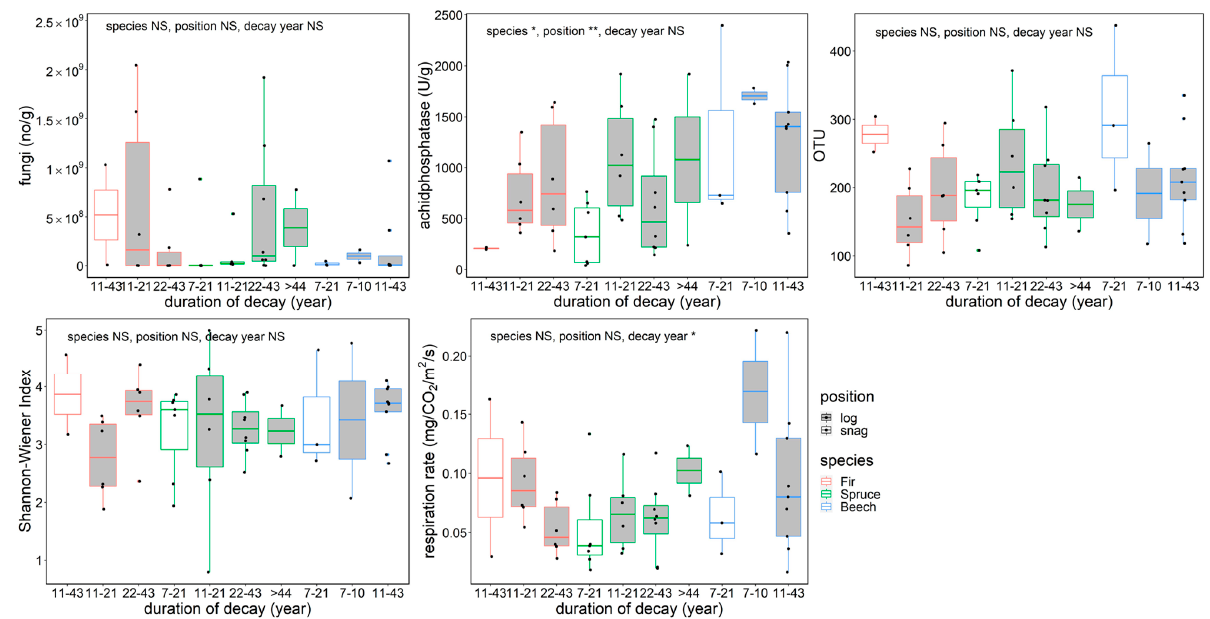
Figure 2. Physico–chemical and biological features and in situ respiration rate of beech, spruce, and fir dead wood snags and logs in an old-growth forest in the Zofin Forest by species and duration of decay. The significance of the effect of tree species, dead wood position, and decay length are indi- cated with asterisks (ANOVA, * p < 0.05, ** p < 0.01).